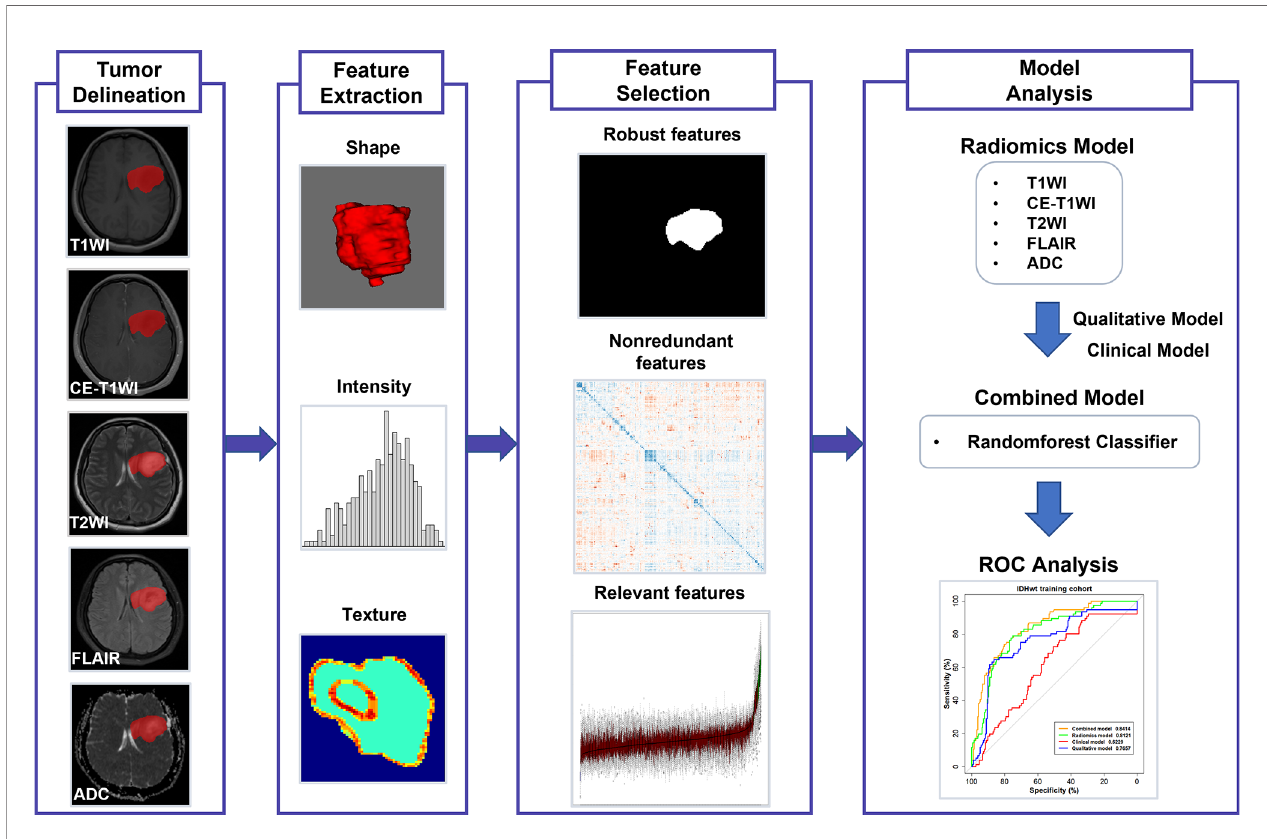
FIGURE 1 | The work fl ow of this